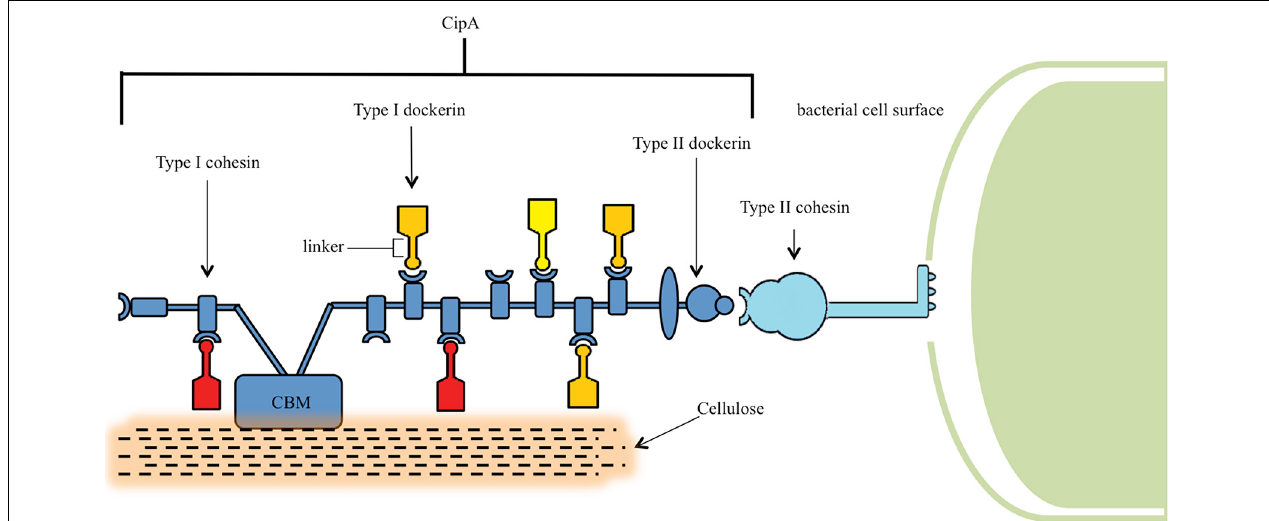
FIGURE 2 | Structure of the cellulosome. The central component of the cellulosome, CipA, is bound to the peptidoglycan layer of C. thermocellum via binding of the Type II cohesin and Type II dockerin domains. CipA also